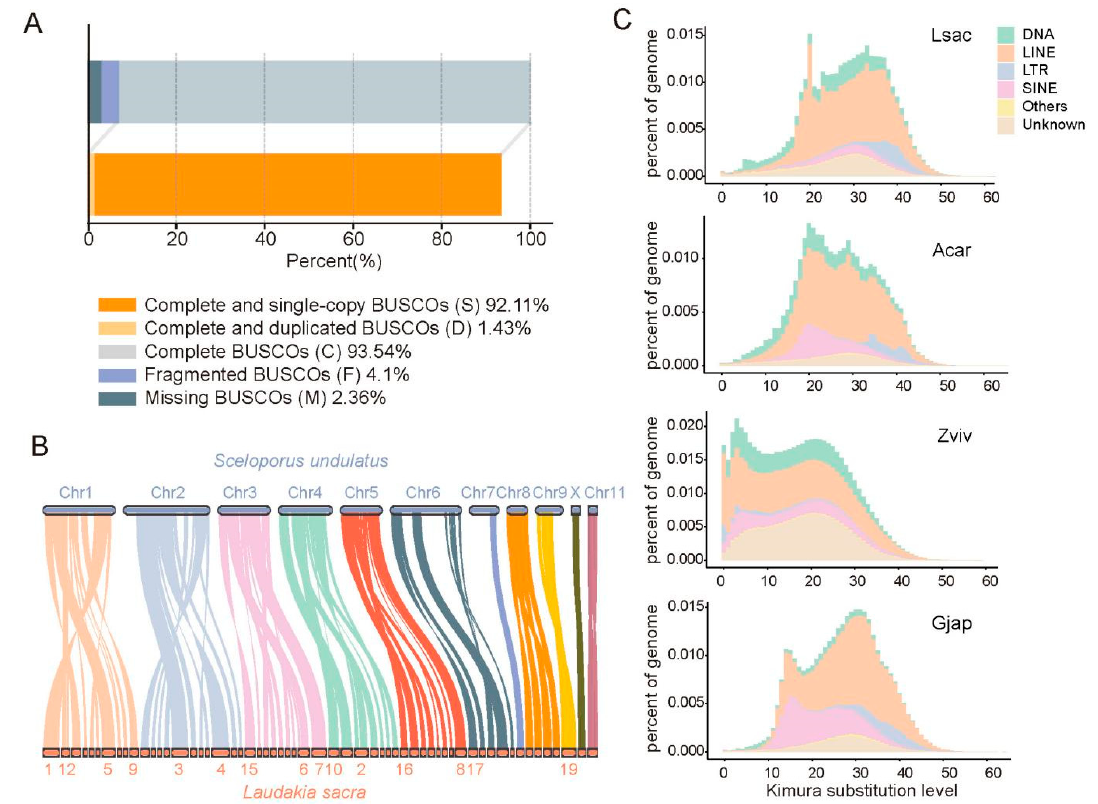
Figure 2. Assessment of Laudakia sacra genome assembly and comparison with other lizard genomes. ( A ) BUSCO assessment of L. sacra assembly. ( B ) Genome-wide synteny between L. sacra and Sceloporus undulatus . ( C ) Transposable element (TE) accumulation history in different lizards. The X-axis is the CpG-adjusted Kimura distance from consensus in TE library. The Y-axis is the percentage of TE occupancy in genome. Copies clustered on right of graph markedly diverged from their corresponding consensus, potentially corresponding to ancient copies, while sequences on the left may correspond to recent copies. Lsac, L. sacra ; Acar, Anolis carolinensis ; Zviv, Zootoca vivipara ; Gjap, Gekko japonicus.